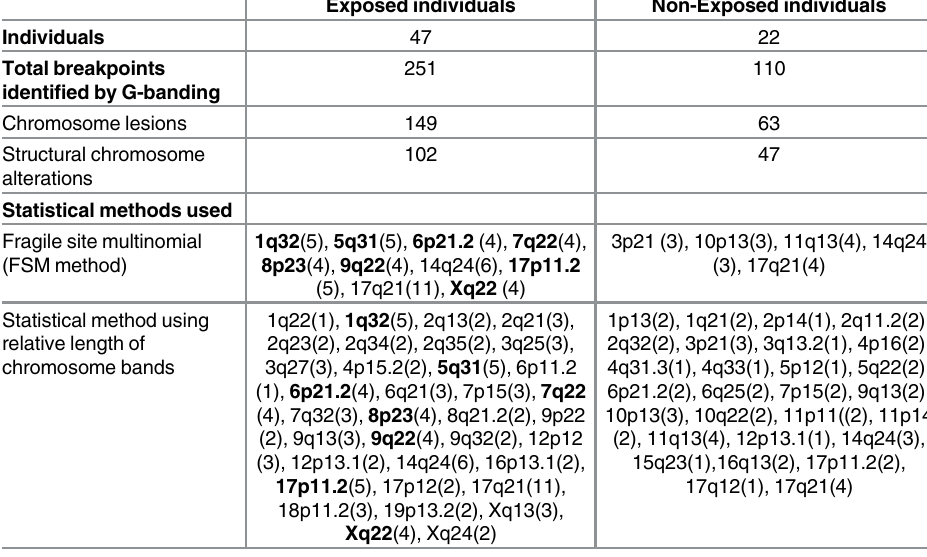
Numbers in parentheses indicate the breaks located in chromosome band. Bold chromosome bands are present only in exposed individuals using two statistical